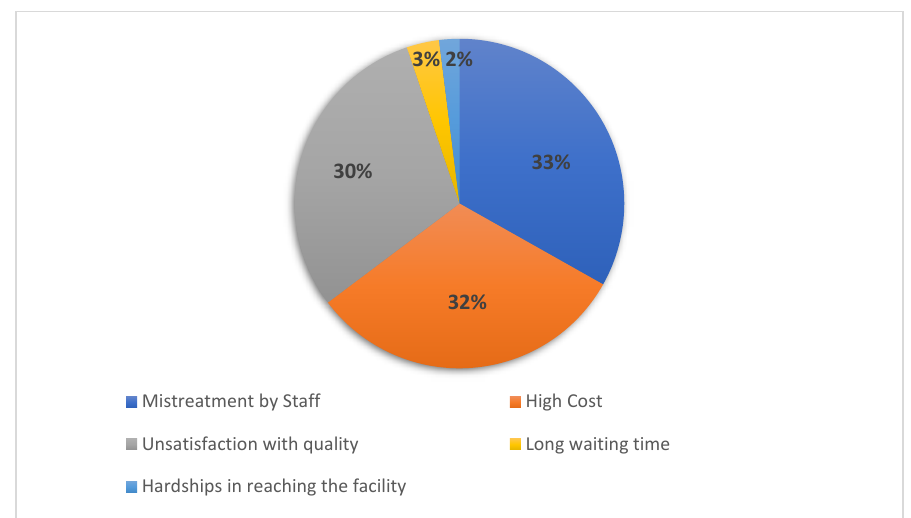
Figure 2. Reasons for not returning to the health facility.